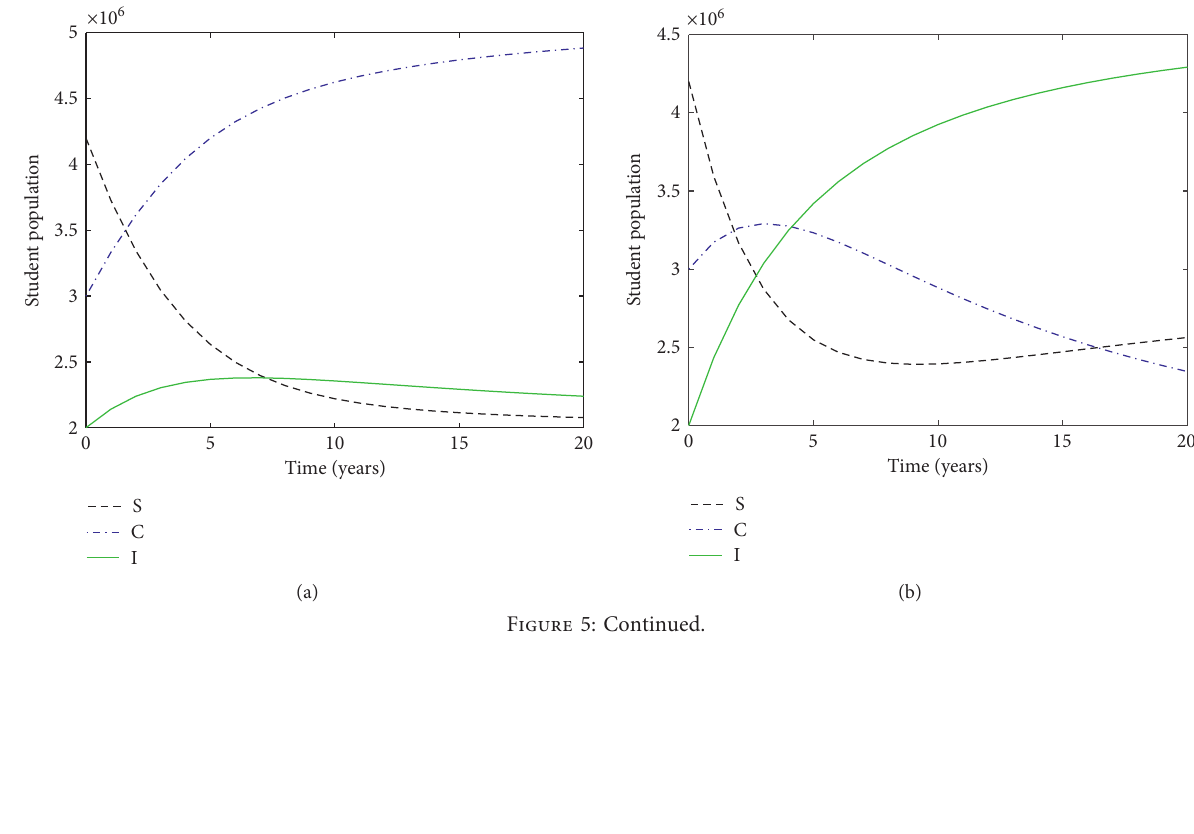
� 2 . 525; (b) σ � 0, α � 0 . 025, R � 1 . 923; (c) σ � 0 0